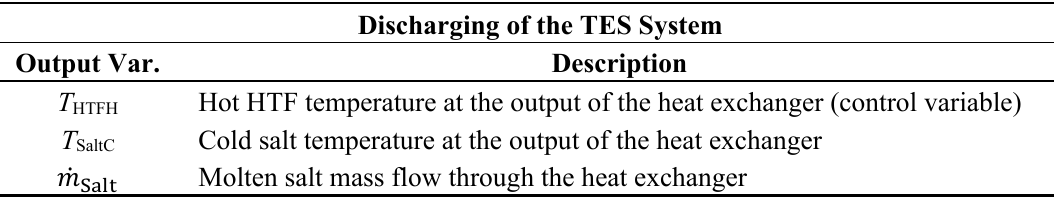
Table 8. TES discharging output variables.